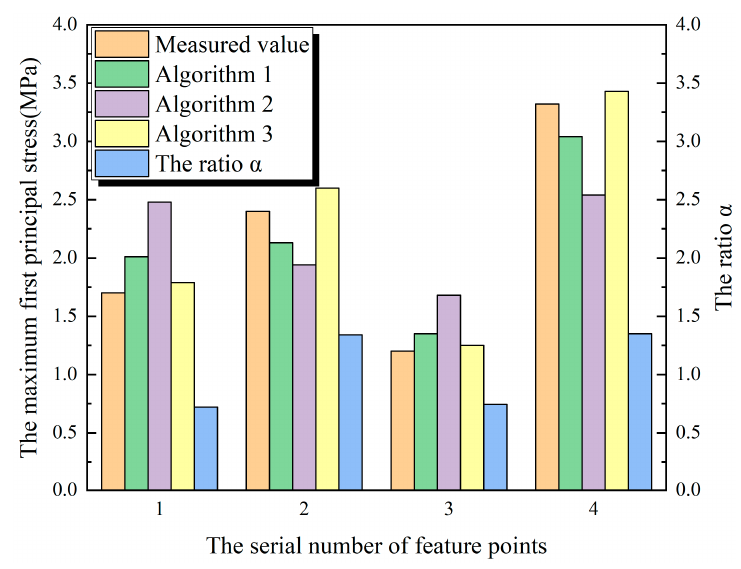
Figure 10. Comparison of three algorithms with engineering measured values.